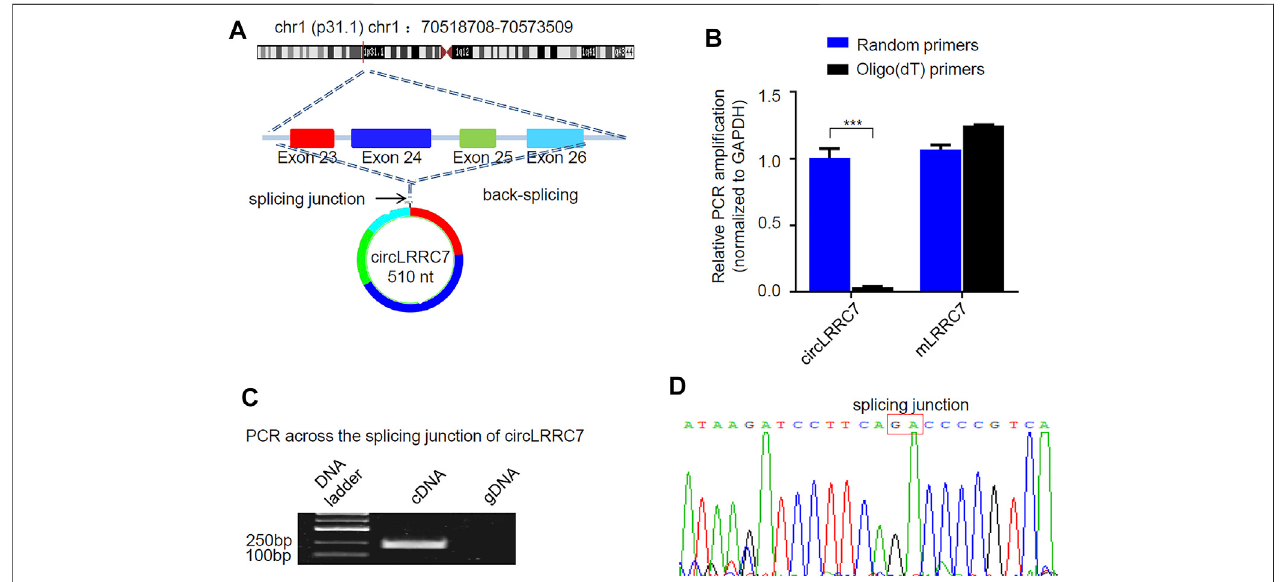
FIGURE 3 | Characterization of circLRRC7. (A) The genomic localization of circLRRC7 in the LRRC gene. (B) Random hexamer and Oligo (dT) primers were used for the reverse transcription followed by qPCR. Oligo (dT) speci fi cally transcribed mRNA, whereas random hexamer transcribed total RNAs. circLRRC7 was ampli fi ed from total RNA template but not mRNA template, whereas the host mLRRC7 was ampli fi ed from both total RNA and mRNA templates. (C) PCR across the splicing junction of circLRRC7 by using genomic DNA (gDNA) or cDNA as template to amplify circLRRC7. circLRRC7 was ampli fi ed from cDNA but not gDNA. (D) Sanger sequencing of the circLRRC7 PCR product. Red box represents splicing junction of circLRRC7. (*** p < 0.001).